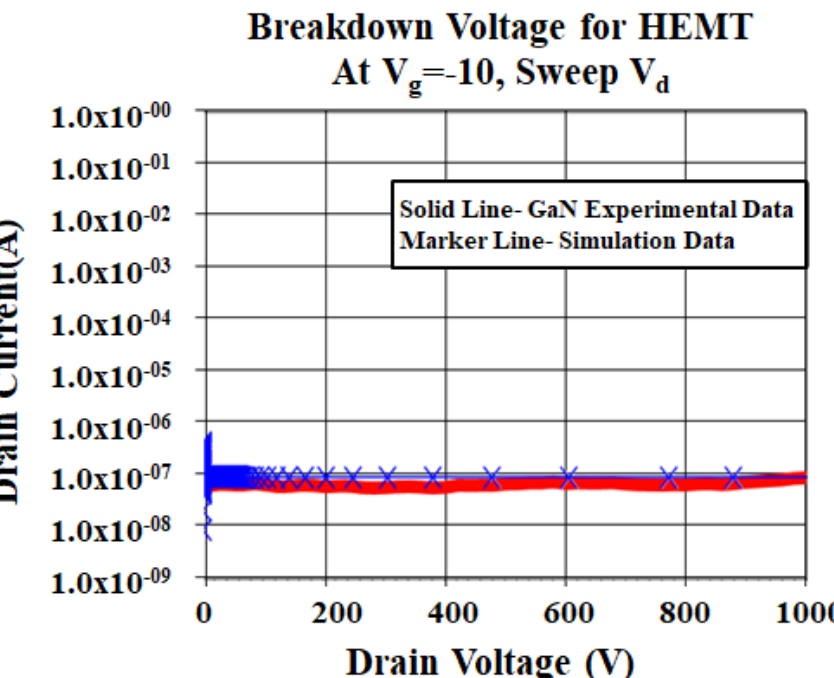
Figure 6. Breakdown voltage curve of the simulated data and GaN wafer experimental data.